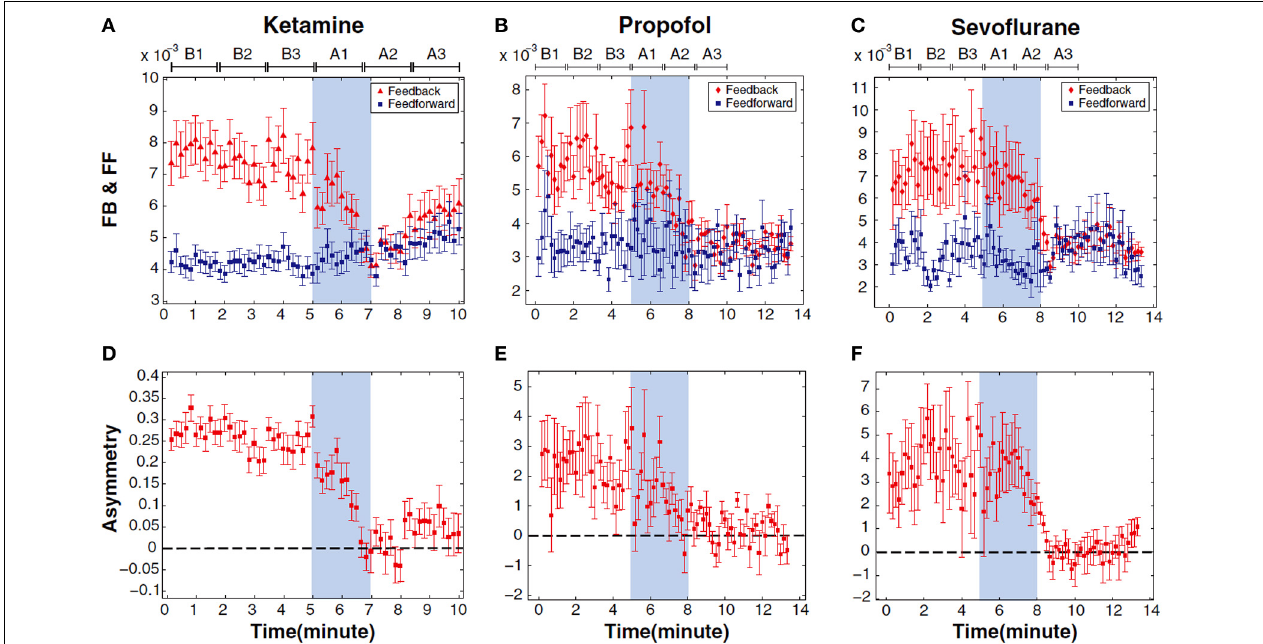
FIGURE 6 | Inhibitionoftop-downconnectivityisacommoncorrelateof anesthetic-inducedunconsciousnessacrossthreedistinctclassesof generalanesthetics. Thisfiguredepictsfrontal-to-parietal(feedback)and parietal-to-frontal(feedforward)connectivitybefore,duringandafter anesthetic-inducedunconsciousnessinsurgicalpatients (A–C) .Lowerpanels (D–F) showasymmetryofdirectionalconnectivity,withpositivevalues representingfeedbackdominanceandnegativevaluesrepresentingfeedforward dominance.Connectivitywasmeasuredusingelectroencephalographyand